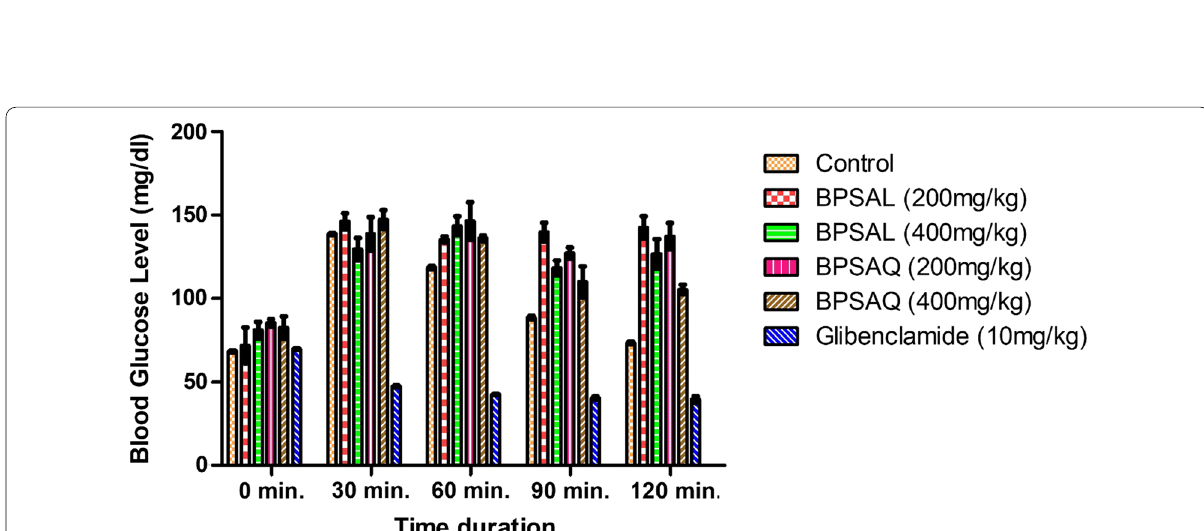
Fig. 9 Three-dimensional view of extracts in various mobile phases in four different mobile phases. Values are expressed as Mean ** P < 0.001 significant from diabetic control group =